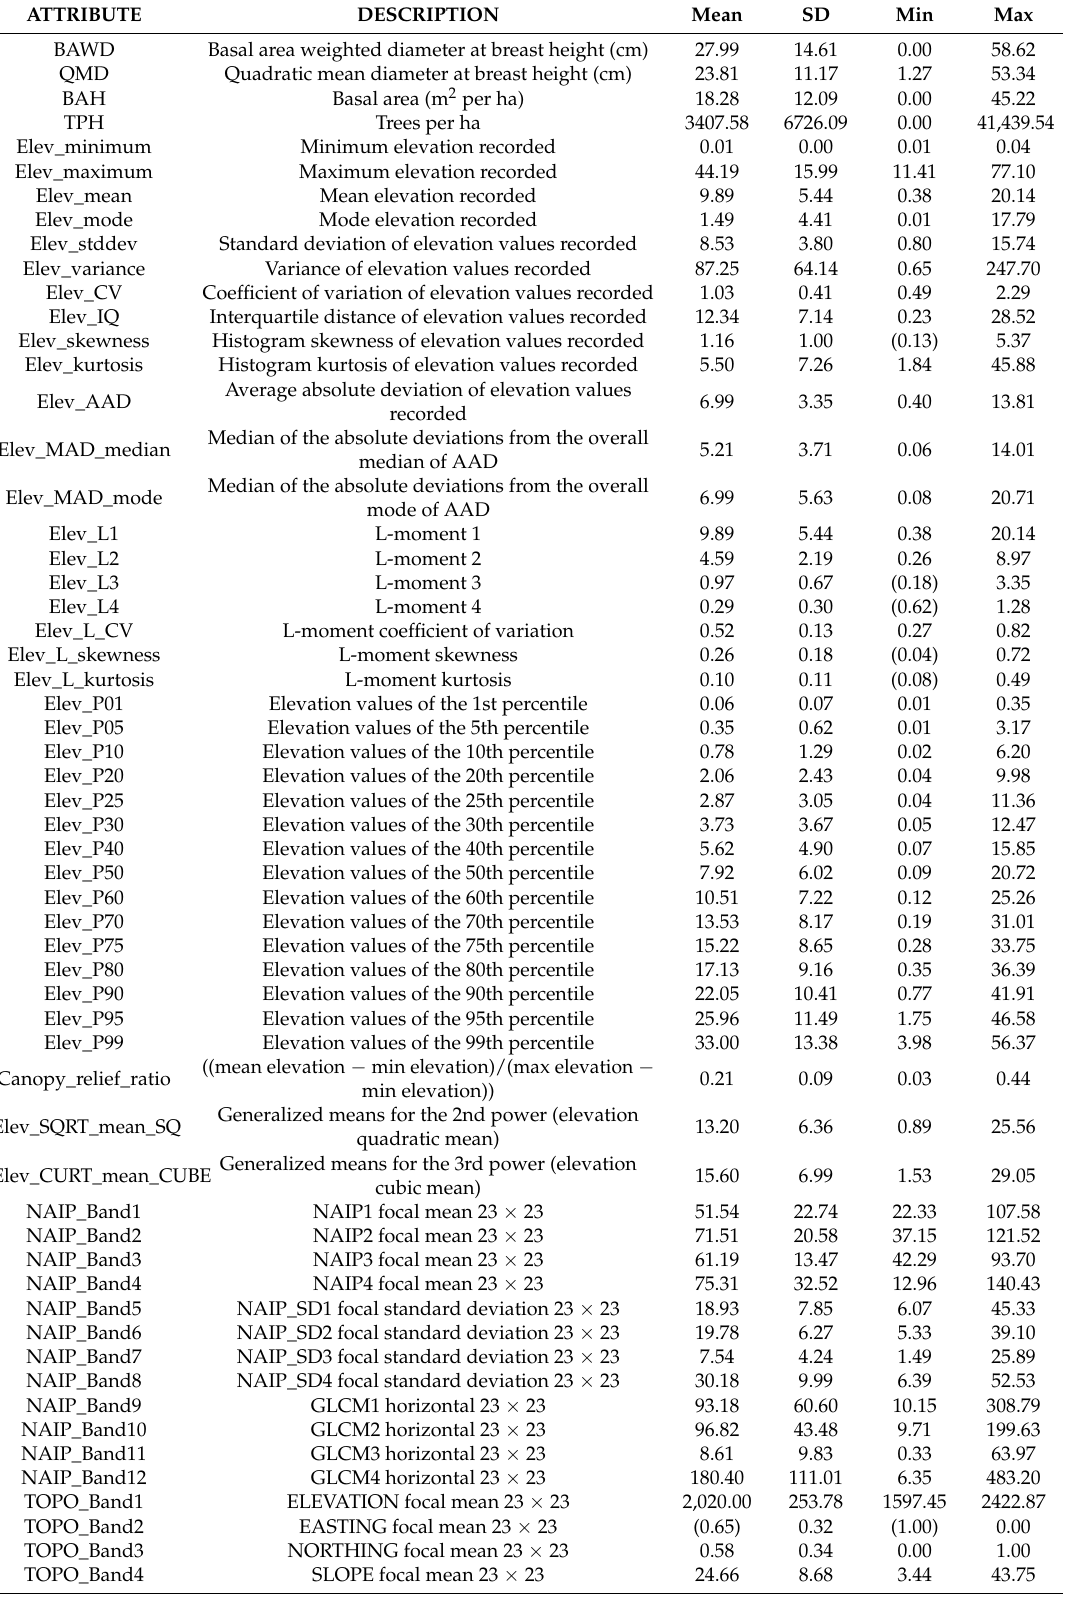
Table A1. Description and summary statics of field and remote sample